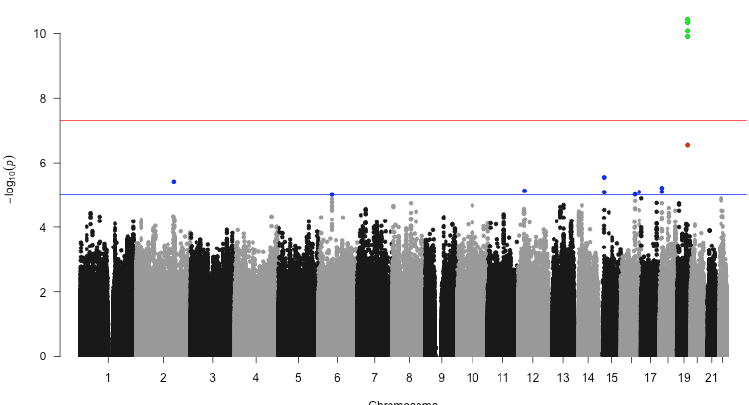
( p ) (y-axis). It shows genome- Figure 2. Scatterplot of chromosomal position (x-axis) against − log 10 wide associations from the significant loci with dementia. The red line indicates the genome-wide significant threshold ( p ≤ 5 × 10 − 8 ) and the blue line indicates the genome-wide suggestive threshold ( p ≤ 1 × 10 − 5 ). We highlighted the SNPs with p ≤ 1 × 10 − 5 in blue points, red points and green points. The green points represent those SNPs that passed the genome-wide significant threshold ( p ≤ 5 × 10 − 8 ), the red point is the SNP that passed the FDR threshold ( p ≤ 0.05) and the other blue points are general SNPs with p ≤ 1 × 10 − 5